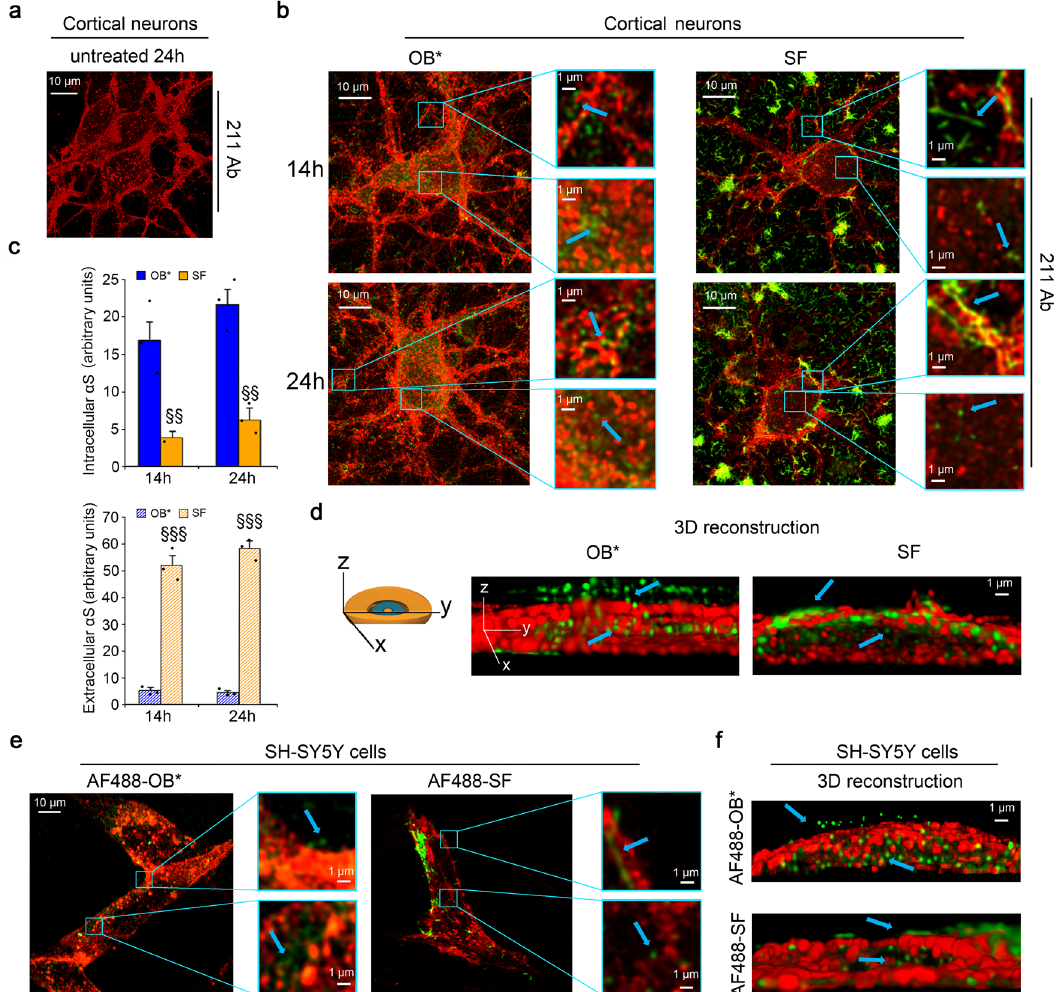
Fig. 5 Visualization of α S fi brils outside and oligomers inside cells at high resolution. a , b Representative STED images of primary rat cortical neurons that were untreated ( a ) or treated ( b ) with OB* (left) and SF (right) for 14 and 24 h. Red and green fl uorescence indicates the cell membranes and the α S species revealed by WGA and the conformation-insensitive and human α S-speci fi c 211 antibodies (sc12767, Santa Cruz Biotechnology), respectively. Higher magni fi cations of the α S species are shown in the boxed areas (three independent experiments with two internal replicates). c Semi-quantitative analysis of the intracellular and extracellular 211-derived fl uorescence data referring to panel ( b ). Experimental errors are S.E.M. ( n = 3 with two internal replicates). Samples were analyzed by one-way ANOVA followed by Bonferroni ’ s multiple comparison test relative to cells treated with OB* for 14 and 24 h (in panel c , §§ P < 0.01, §§§ P < 0.001). d 3D reconstruction of the z-stack analysis (5- μ m-thick slices) of the specimens shown in panel ( b ). A primary neuron was virtually dissected on the zy plane to show more clearly the extracellular (top) and intracellular (middle) α S species. A total of 40 – 60 cells were analyzed per condition (three independent experiments with four internal replicates). e Representative STED images of SH-SY5Y cells that were treated with AF488-OB* (left) and AF488-SF (right) for 24 h. Red and green fl uorescence indicates the cell membranes labeled with WGA and α S labeled with AF488 dye, respectively. Higher magni fi cations of the α S species are shown in the boxed areas (three independent experiments with one internal replicate). f 3D reconstruction of the z-stack analysis (5- μ m-thick slices) of the specimens shown in panel ( e ). Other details as in panel d (three independent experiments with one internal replicate). In all panels blue arrows indicate either fi brillar or oligomeric α S